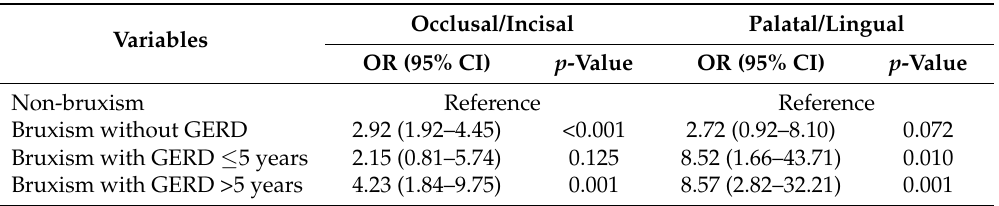
Table 5. Associations among bruxism, GERD, and severe tooth wear for different tooth surfaces after adjustment 1 .